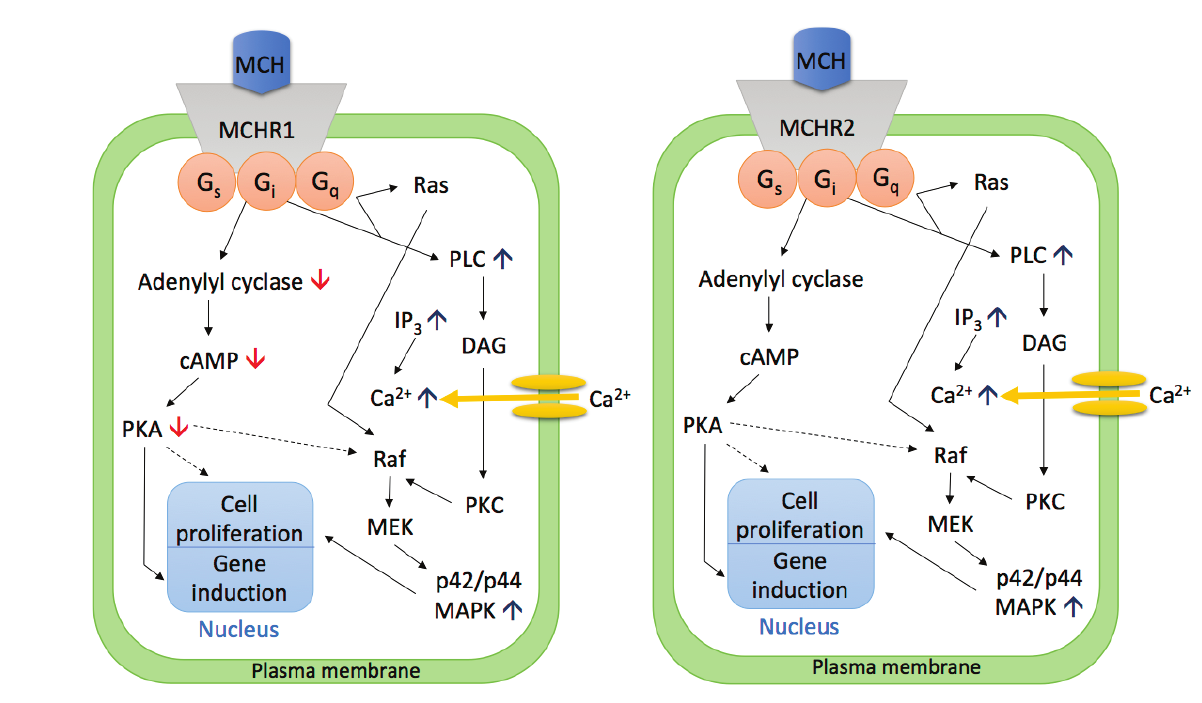
Figure 5: Signalling pathways of melanin-concentrating hormone receptor 1 (MCHR1) (left panel) and MCHR2 (right panel). MCH binding to receptors leading to G protein coupling (Gs, Gi, Gq). While, Gi activation causing decreased amount of cAMP (red arrows), Gq resulting in increased mitogen-activated protein kinase (MAPK) activity (blue arrows) via Ras and elevation of intracellular calcium level (mediated by inositol trisphosphate (IP3) and phospholipase C (PLC) activation). This cascade induces changes in cell proliferation and gene transcrip- tion. [Protein kinase A=PKA; protein kinase C=PKC; diacylglycerol=DAG; MAPK kinase=MEK] (Adapted from Presse et al.